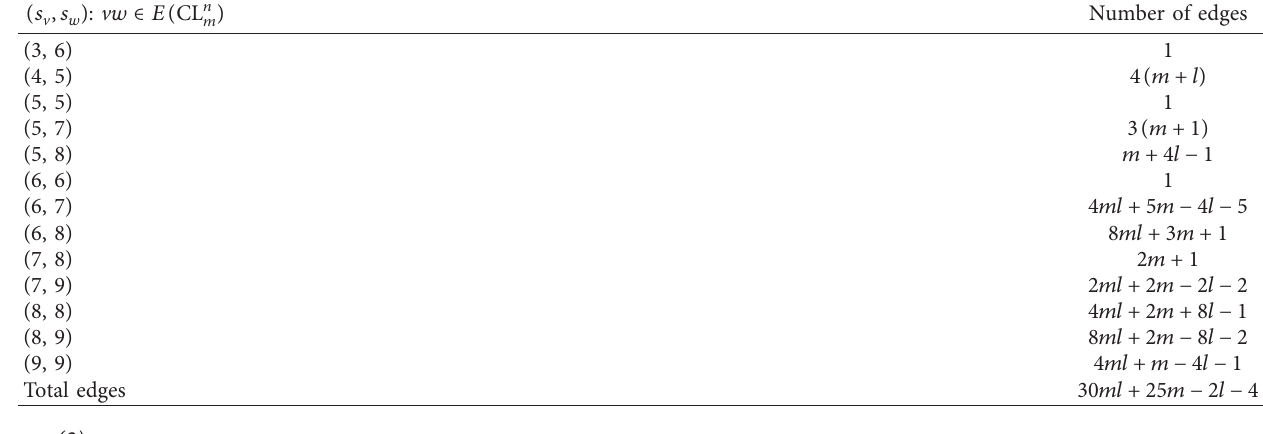
Table 4: Partitioning of the edge set with respect to neighbor’s degree sum of end vertices for CL n ( s ,s ) : vw ∈ E ( CL n v w m